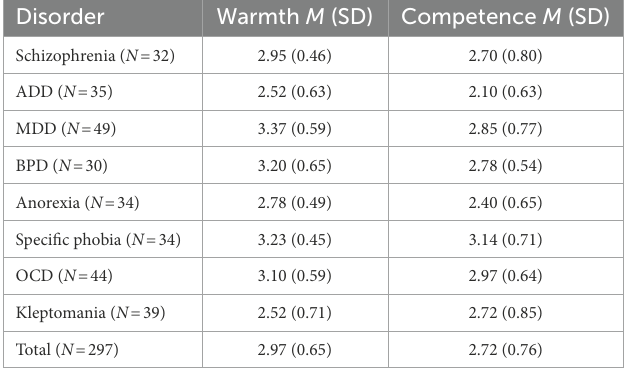
TABLE 1 Means and standard deviations of warmth and competence ratings for disorders in the general public.